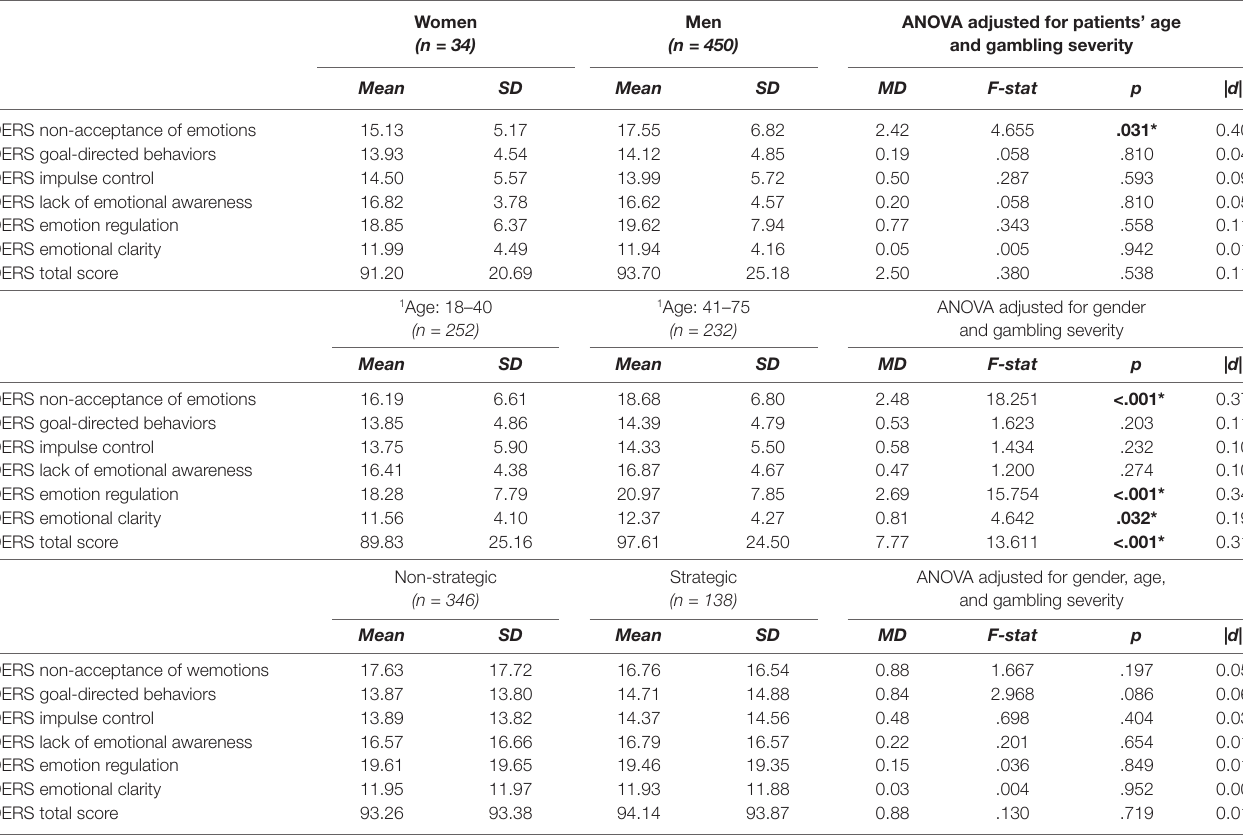
TABLE 2 | Comparison of the DERS scores based on gender, age, and gambling